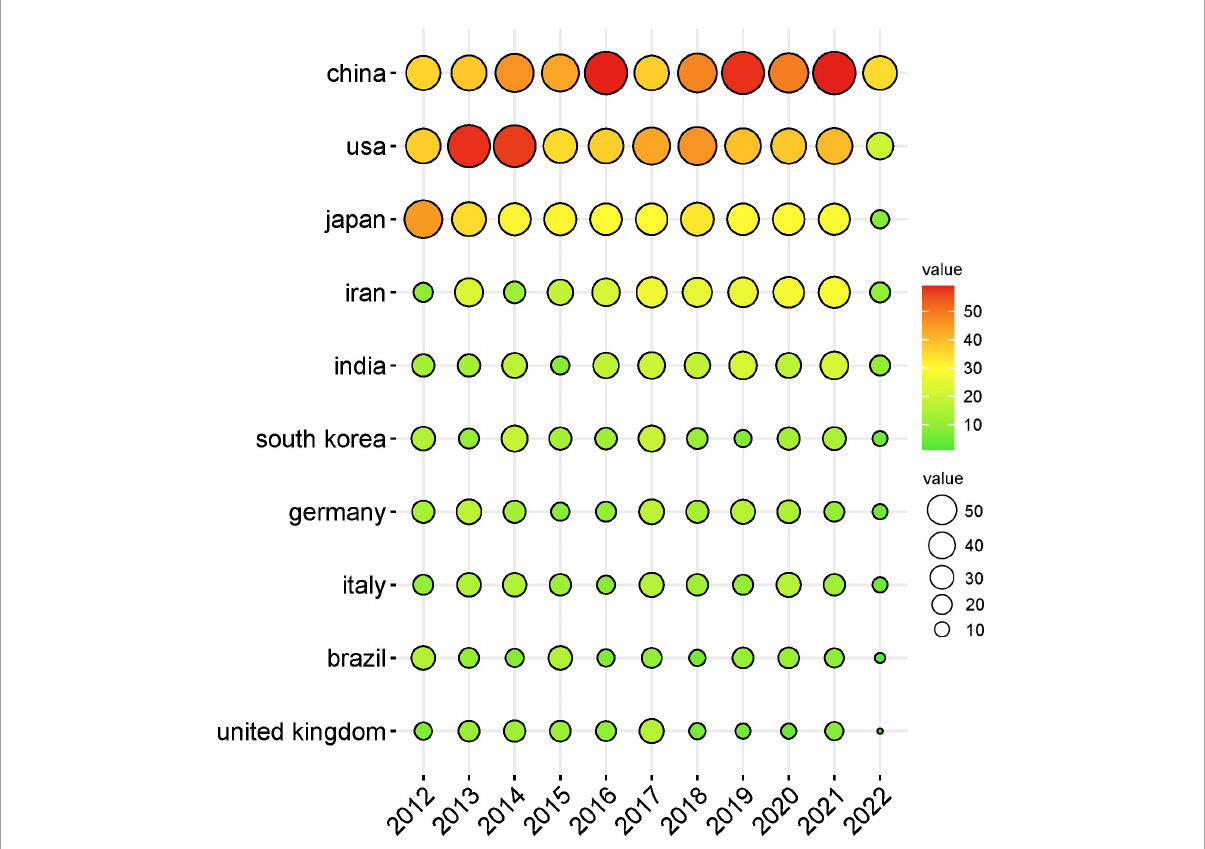
FIGURE4 Top 10 countries/regions of annual publications on Helicobacter pylori -related gastric ulcer (GU) research, from 2012 to 2022. A country’s number of articles issued is directly proportional to the size of the circle and the color of the circle from green to